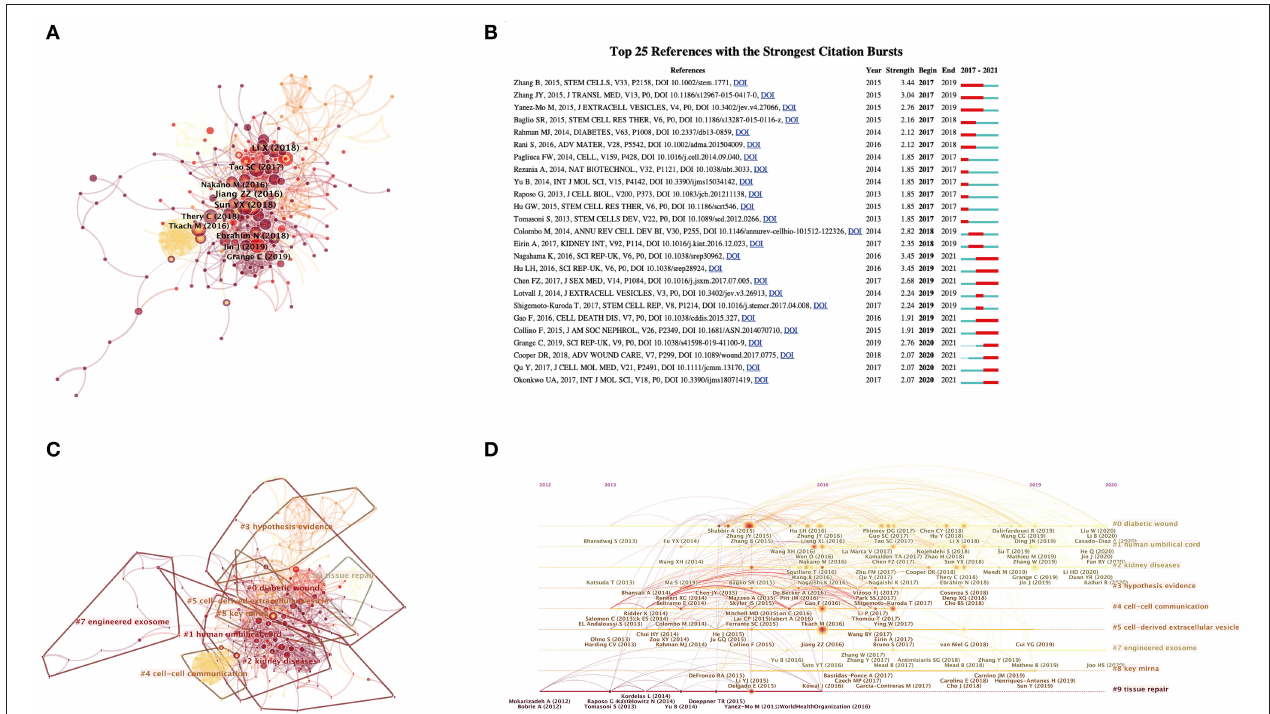
FIGURE 4 | Mapping of references in studies on SC-EVs for diabetes. (A) A simplified co-citation network of references on SC-EVs for diabetes based on CiteSpace, and burst references are represented by red nodes. (B) The top 25 references with the strongest citation bursts based on CiteSpace. (C) Title clustering analysis of the co-citation network based on CiteSpace. (D) Timeline visualization of references from 2012 to 2020.